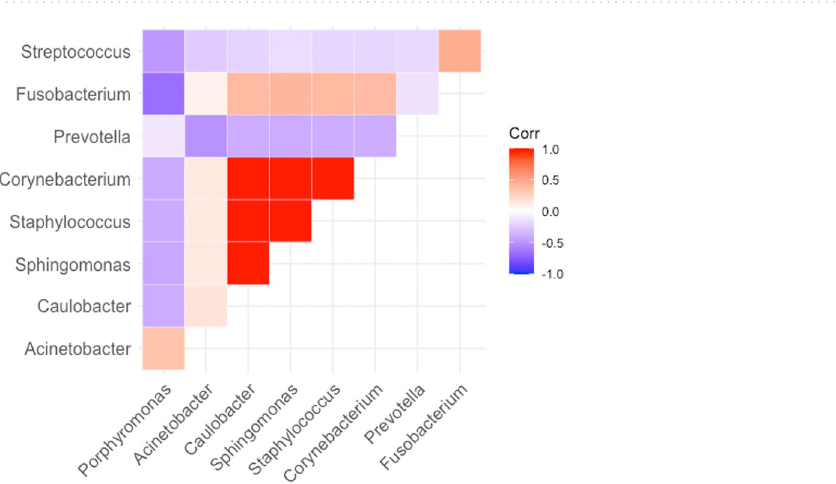
Figure 6. Boxplot of Porphyromonas proportion in ( A ) nasal-oral paired samples ( B ) all nasal samples in ORS group and nORS group.